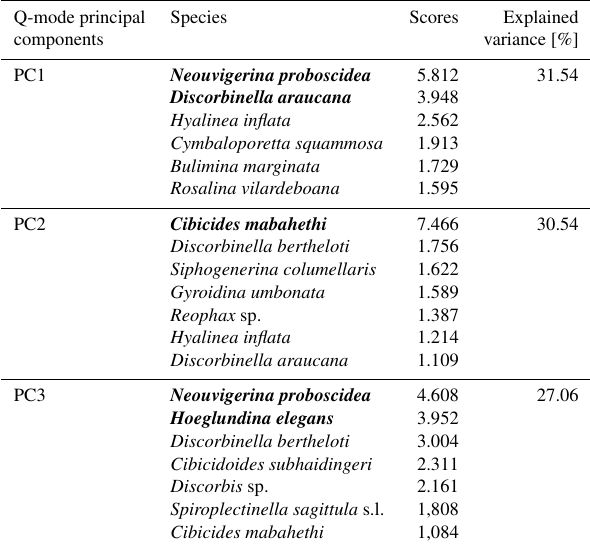
Table 2. Species composition of benthic foraminiferal assemblages. Principal component number, dominant (bold) and important asso- ciated species with principal component scores (Q-mode) and ex- plained variance in percent of total variance are